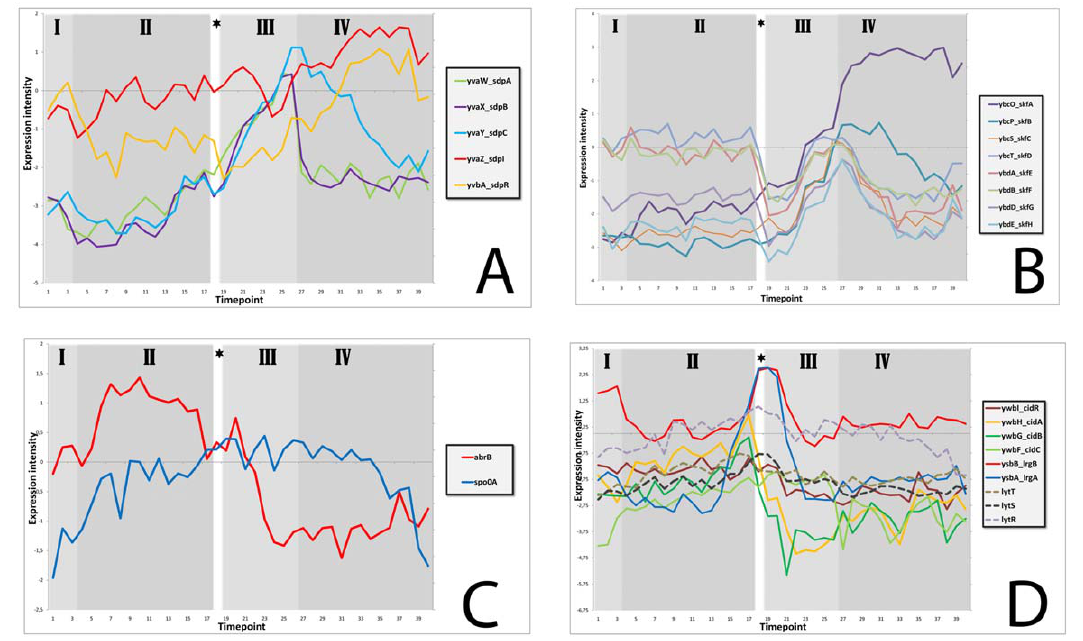
Figure 2. Expression profiles of genes involved in the production of toxic proteins. A) The sdp operon. B) The skf operon. C) The regulators AbrB and Spo0A. D) Antiholin lrgAB , holin cidA , remaining members of operon ywbGF , putative regulator ywbI , and the lytST two-component regulatory system.